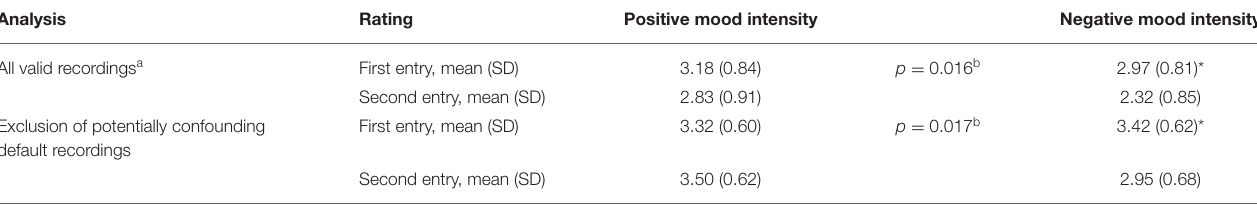
TABLE 3 | Positive and negative mood intensity ratings. Analysis